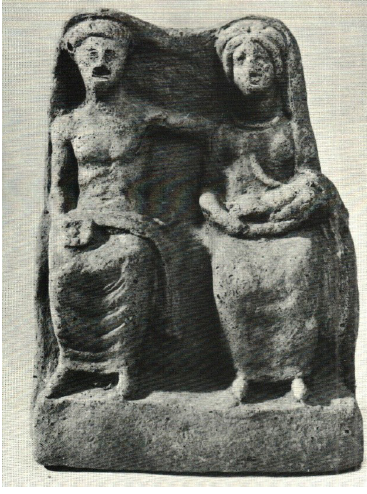
Figure 1. Gabii. From Almagro-Gorbea, “El santuario”, 271, n. 10, Tav. LI